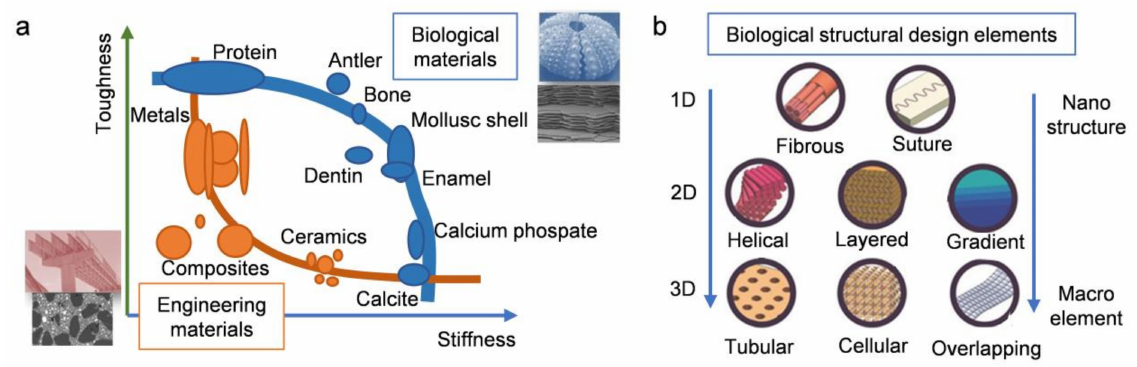
Figure 1. ( a ) Toughness and stiffness for different materials. ( b ) Diagram of the eight most common biological structural design elements. Reprinted with permission from [6], copyright 2018 WILEY-V C H VERLAG